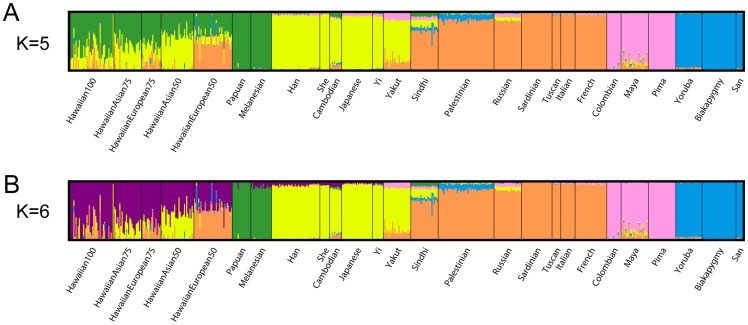
ADMIXTURE clustering of Native Hawaiians for K = 5 (A) and K = 6 (B).
Figures 1A and 1B
 illustrate the clustering of Native Hawaiians and HGDP samples based on GWAS data.Each vertical bar represents an individual's proportion of K ancestral clusters (i.e. color) as estimated by ADMIXTURE.